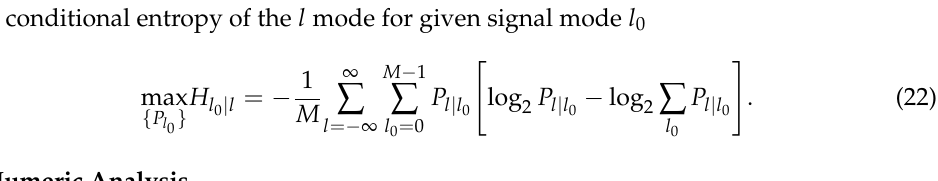
Figure 3. BER of the coaxial double − position power Gaussian vortex carrier communication link versus dimensionless parameter |